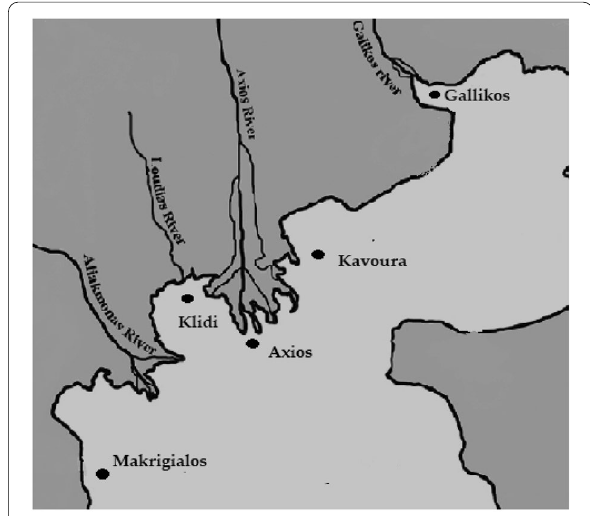
Fig. 1 Sampling area of the study, in Thermaikos gulf, in Central